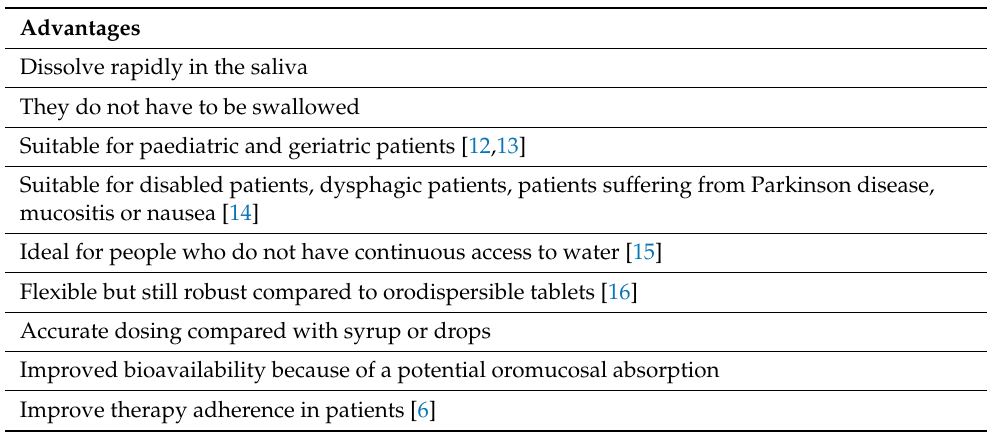
Table 1. Advantages of orodispersible films (ODF) in comparison to traditional oral dosage forms.